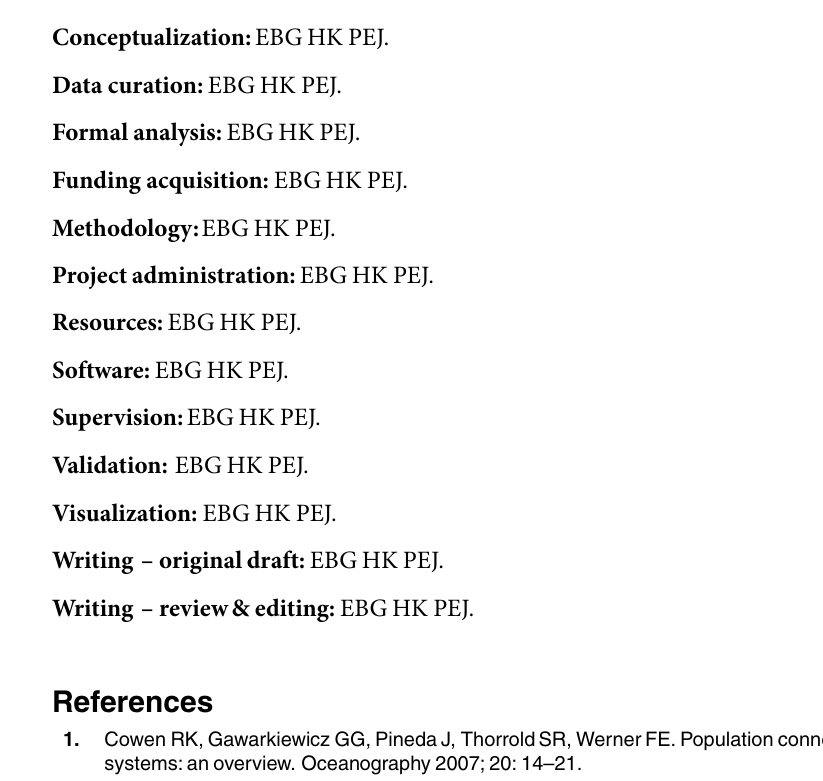
colours denote inferred clusters ( K = 2 to 5). The right graph shows Δ K for different numbers of genetic clusters, suggesting K = 2 as the most likely outcome. S1 Table. Genetic variability at nine microsatellite loci. A = number of alleles, H T = gene diversity in the total material; F ST = estimate of θ (Weir & Cockerham 1984). Numbers in bold indicate statistical significant tests at 1% level after the False Discovery Rate approach (Benja- mini & Hochberg